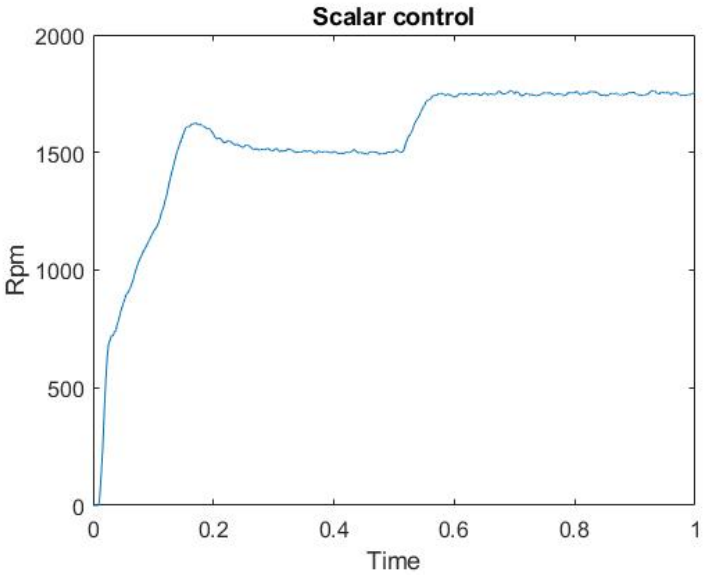
Figure 19. Scalar